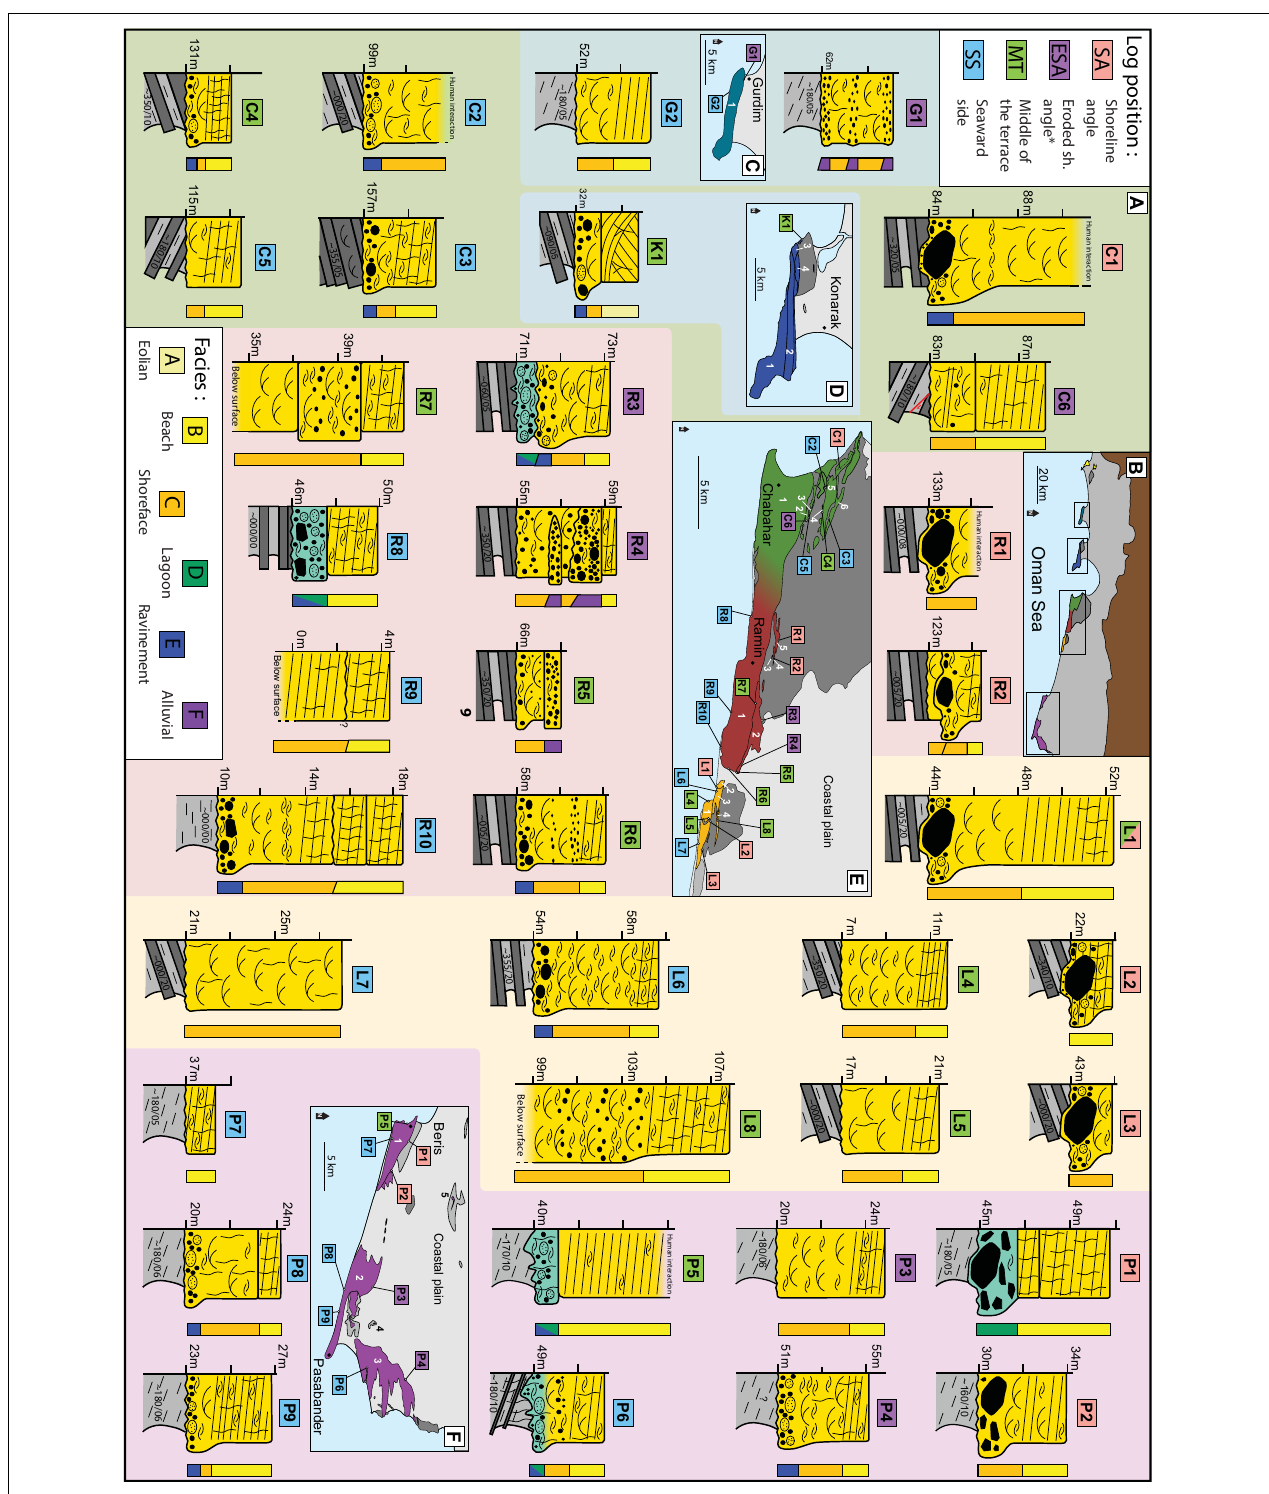
FIGURE 6 | Sedimentary logs of the terrace deposits and their location. Outcrop pictures of such logs are reported in the data repository (Normand et al., 2019a). (A) Sedimentary logs, arranged from shoreline angle (top of the picture) to seaward side (bottom). Colors of the background correspond to the terrace region from which they were measured (see maps). Legends are found in Figure 5 . ∗ Eroded shoreline angle (ESA): Logged at the back of the terrace, when the paleocliff (and the shoreline angle) is eroded (e.g., Figures 4D,F ). (B–F) Localization of the logs of Gurdim (turquoise), Konarak (blue), Chabahar (green), Ramin (red), Lipar (yellow), and Pasabander